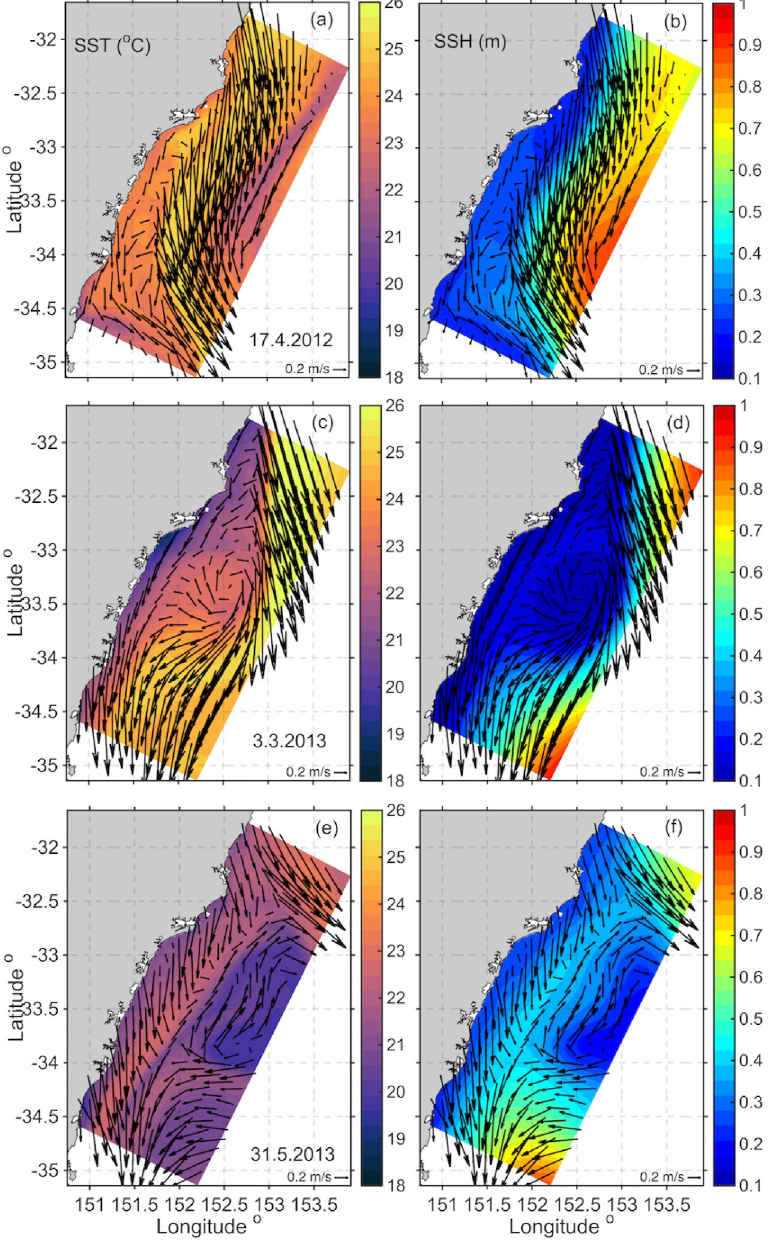
Fig 13. Snapshots of the three circulation scenarios shown in Fig 12. SST from the HSM model (left), and SSH with contours every 0.05m (right). Surface current vectors are shown, plotted every 25th grid cell. For (a, b) Scenario 1, 17 Apr 2012, (c, d) Scenario 2, 3 Mar 2013, and (e, f) Scenario 3, 31 May 2013. The snapshots in Fig 13 show examples of onshore transport, cooler SST and lower SSH by the coast associated with eddy features (Fig 13C and 13D). Upon closer inspection of the trans- ports on the shelf in the region, divergent circulation patterns appear when counter rotating eddies dominate the region, and shelf transports can oppose each other (see Fig 12C). This sce- nario also appeared in the eddy dipole of Malan et al. [53] although the onshore flow associated